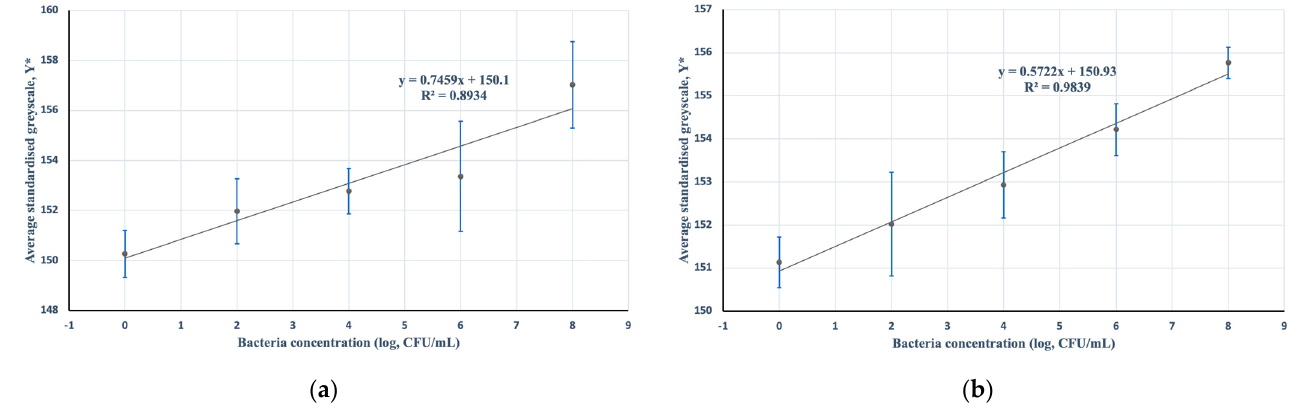
Figure 7. Data of the average standardized greyscale values of MTT-PMS strips against the log of bacteria concentration for two additional incubation periods ( n = 5): ( a ) 15 min; ( b ) 25 min. F-statistic of both regressions against a null of no model predictive capability were found to be F = 25.13 ( p < 0.05) and 183.14 ( p < 0.001), respectively.